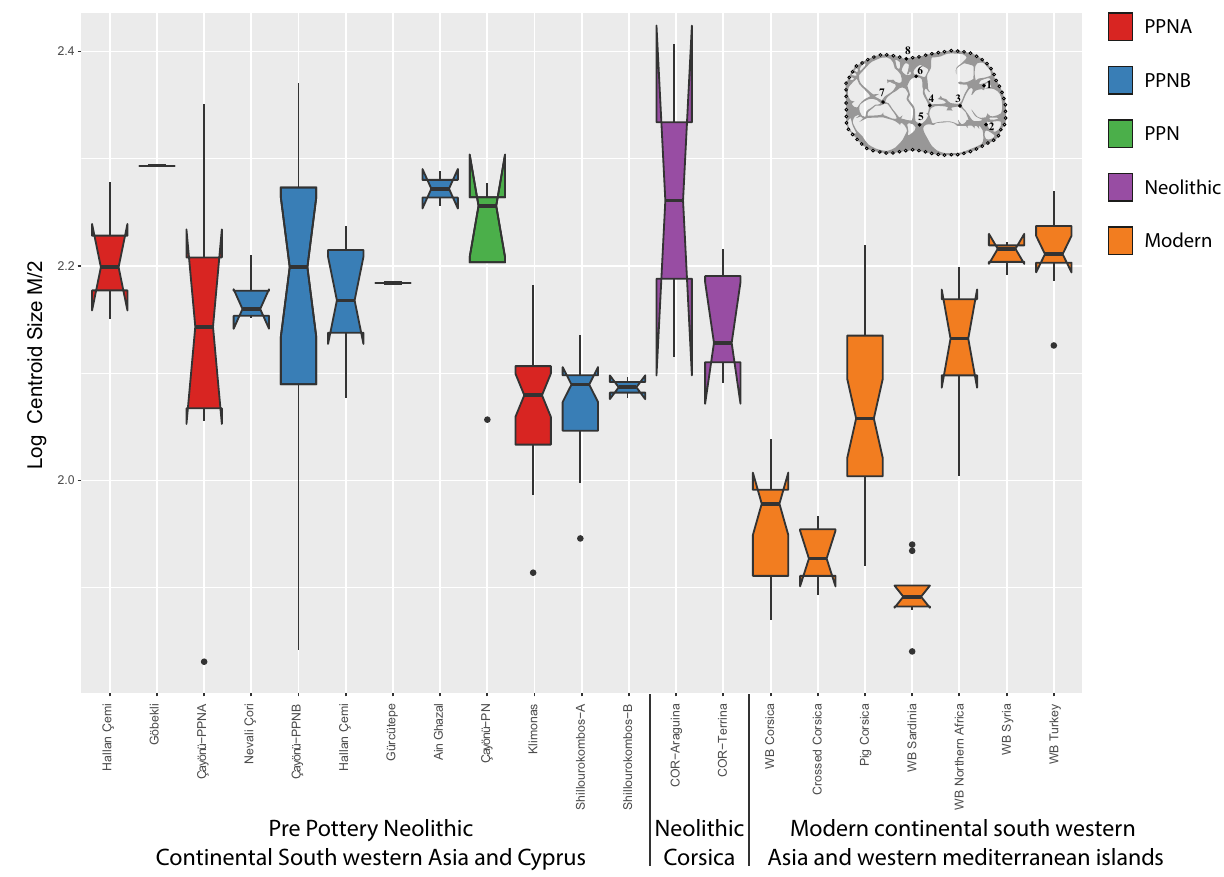
Figure 4. M/2 log(C Size) variation in extant and archaeological Sus scrofa displayed with box plots. The boxes represent 75% of the variation, the bold bar is the median and the vertical line the minimum and maximum extremities. Outliers are visualized by